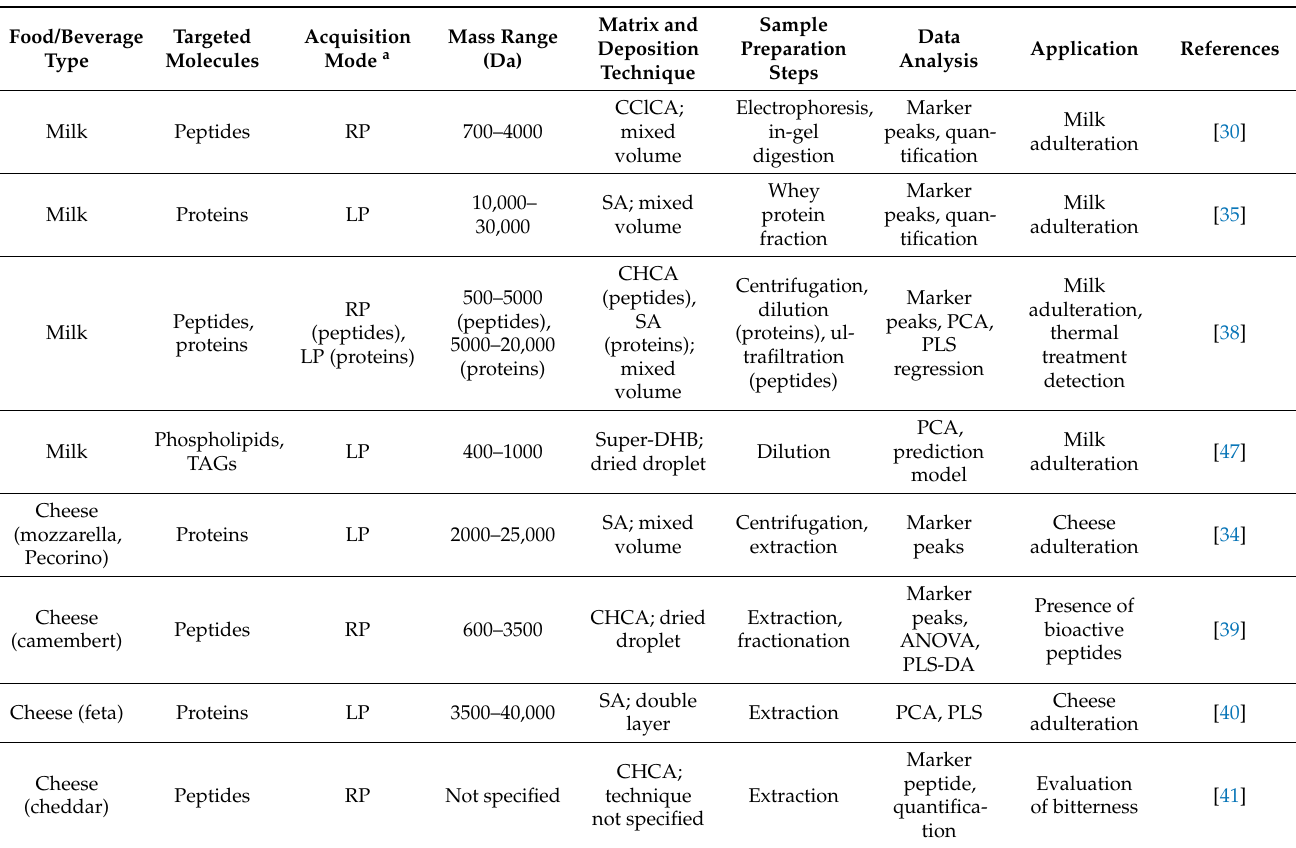
Table 2. The use of MALDI-TOF MS for molecular profiling in food analysis. This table provides condensed but concise information regarding the sample type, targeted molecules, experimental conditions and sample treatment, data processing strategies, and application